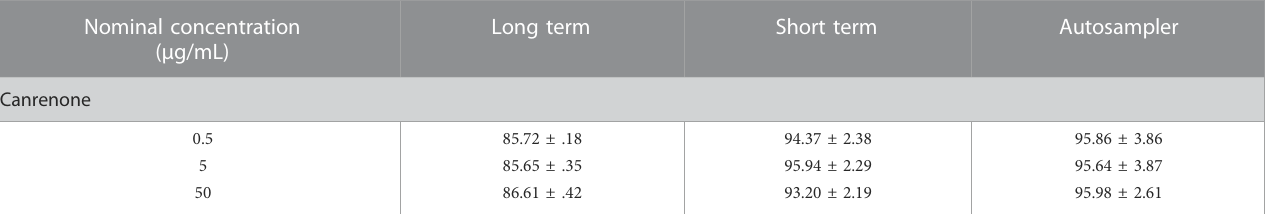
Long term Short term